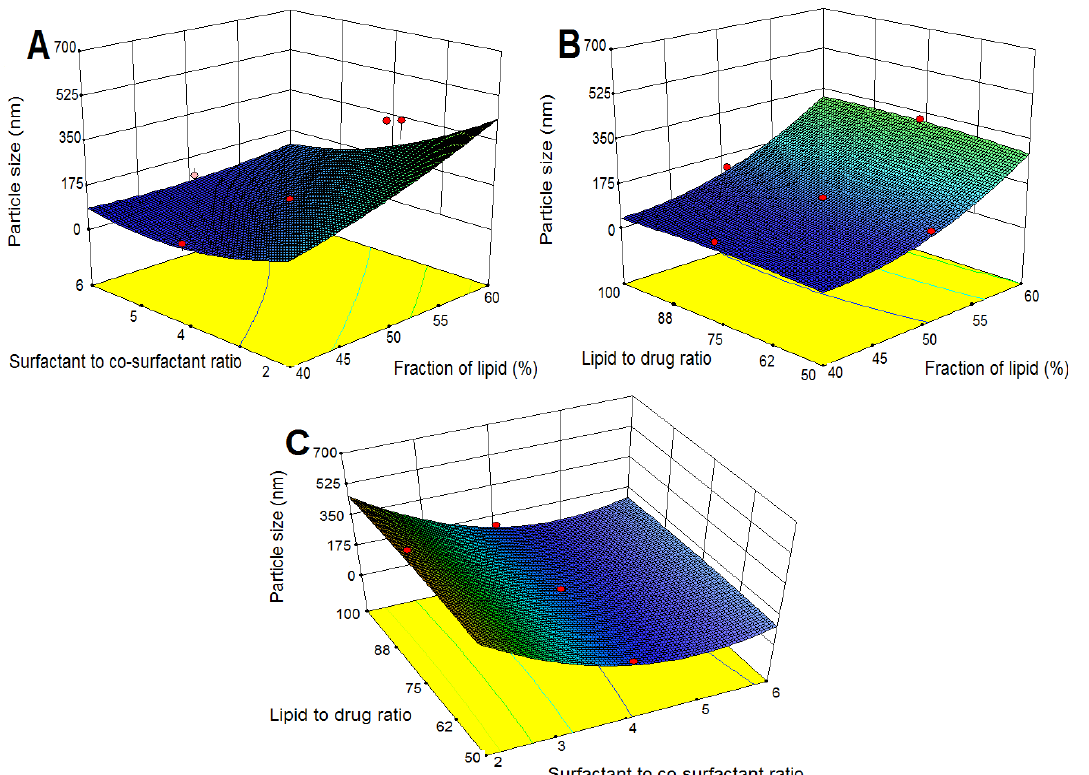
Figure 1. Response surface plots showing the effects of variables on particle size of TP-SLN. ( A ) fraction of lipid and surfactant to co-surfactant ratio, ( B ) fraction of lipid and lipid to drug ratio, and ( C ) surfactant to co-surfactant ratio and lipid to drug